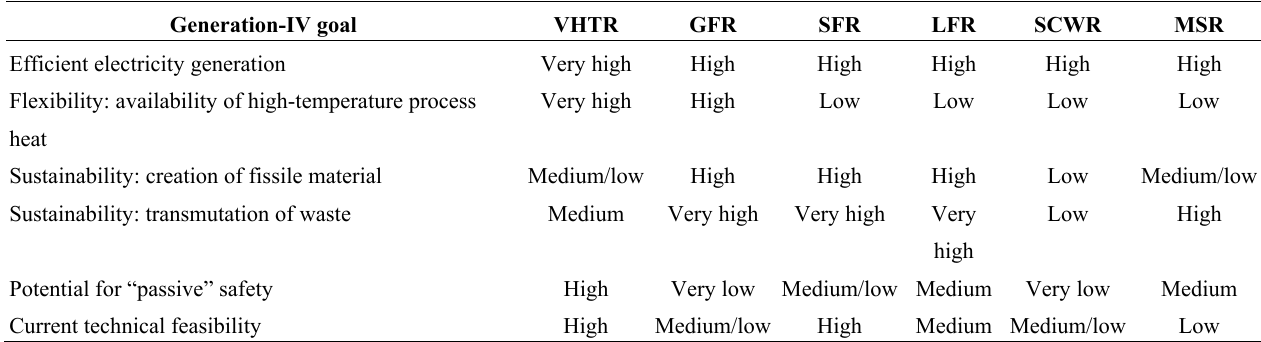
Table 5. Potential of reactor design to meet different Generation-IV goals. © 2008 Elsevier, reproduced with permission from